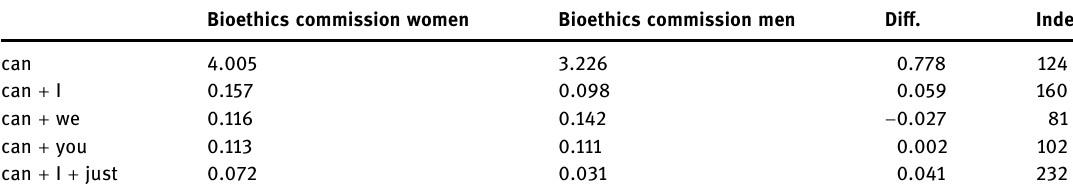
Bioethics commission women